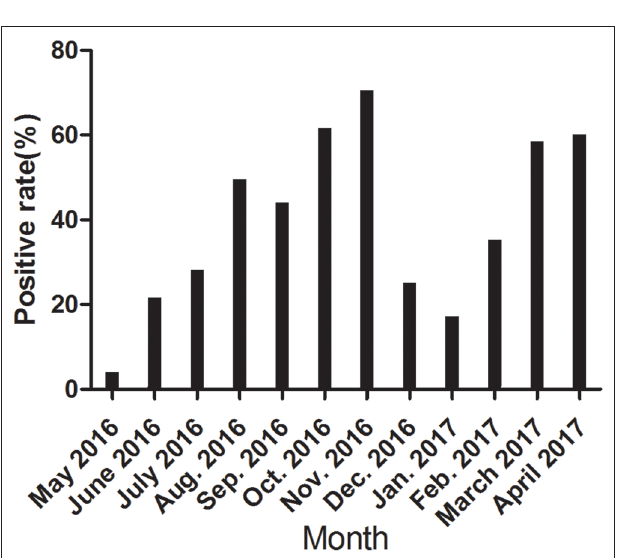
FIGURE 3 | The positive rate of CanineCV antibody every month from May 2016 to April 2017.